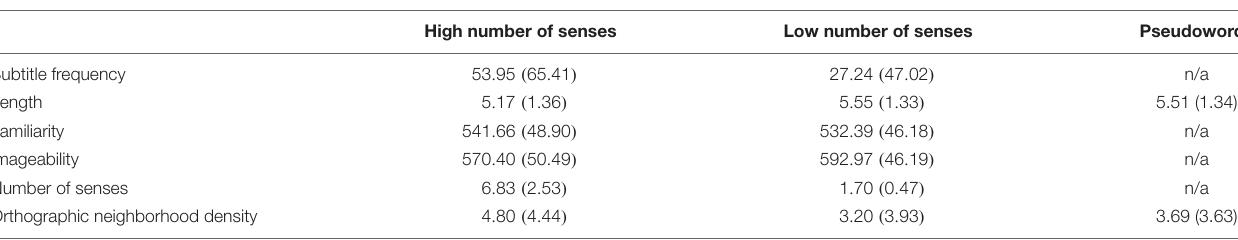
TABLE 2 | Psycholinguistic properties of English items.